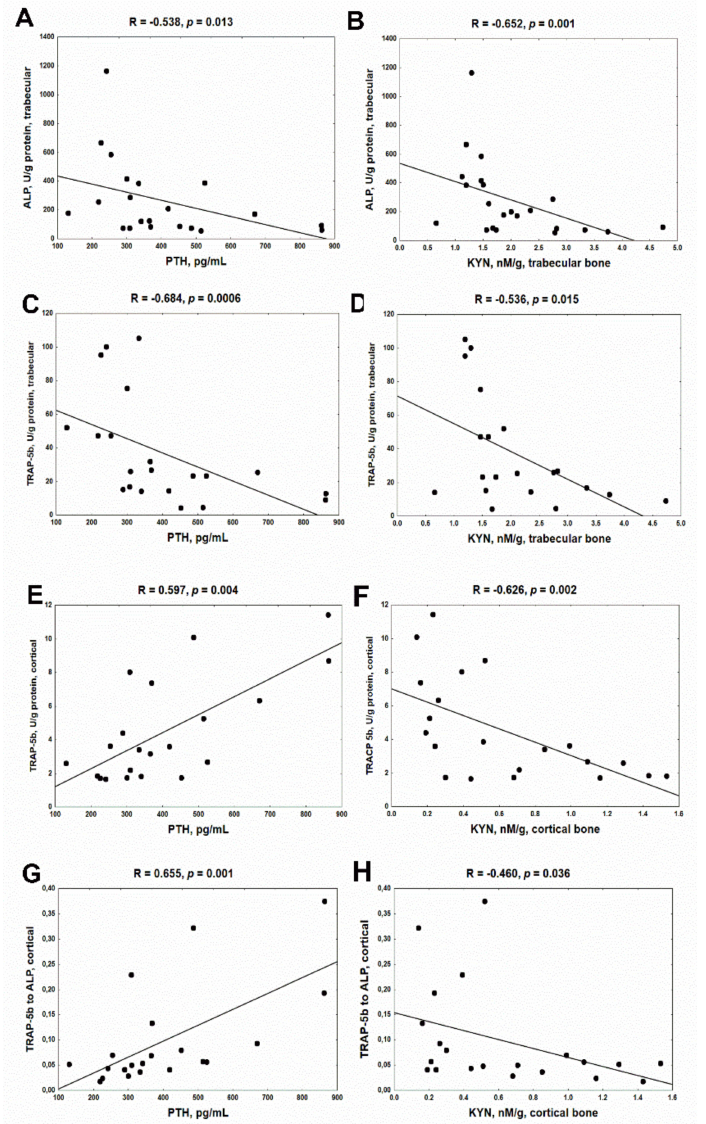
Figure 3. The association between bone turnover markers and serum PTH ( A,C,E,G ) and bone KYN ( B,D,F,H ) in young rats with chronic kidney disease (CKD). Abbreviations: ALP = alkaline phosphatase; CKD = chronic kidney disease; TRAP-5b = tartrate—resistant acid phosphatase 5b; PTH = parathyroid hormone; KYN =